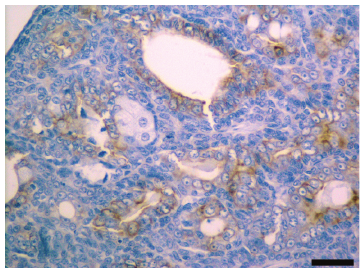
Figure 3: Luminal tumor cells are positive for CK19. Immunohisto- chemistry for CK19 with hematoxylin counterstain. Bar = 50 𝜇 m.